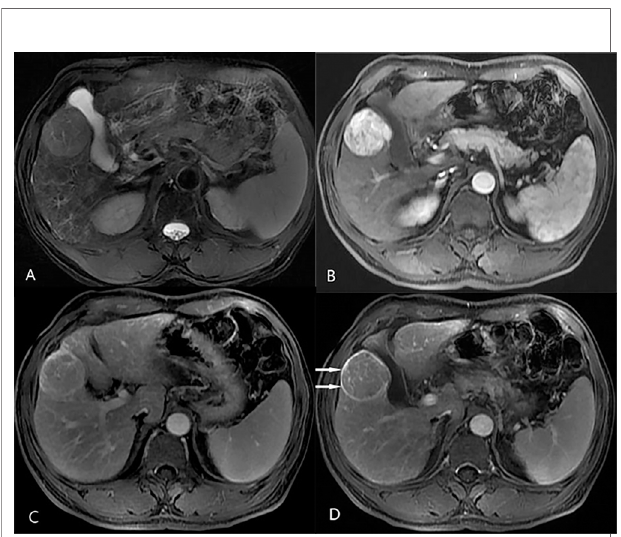
FIGURE 2 | Axial MR images in a 63-year-old man with hepatitis B-related liver cirrhosis and hepatocellular carcinoma that satis fi es the LR-5 criteria. (A) T2- weighted image shows a 49-mm nodule with mildly homogeneous hyperintensity in hepatic segment V. The nodule shows non-rim hyperenhancement in (B) the arterial phase and nonperipheral washout in (C) the portal venous phase. An enhancing capsule is also observed in (D) the delay Table 5 ): MVI positivity in HCC was mostly classi fi ed as LR-5